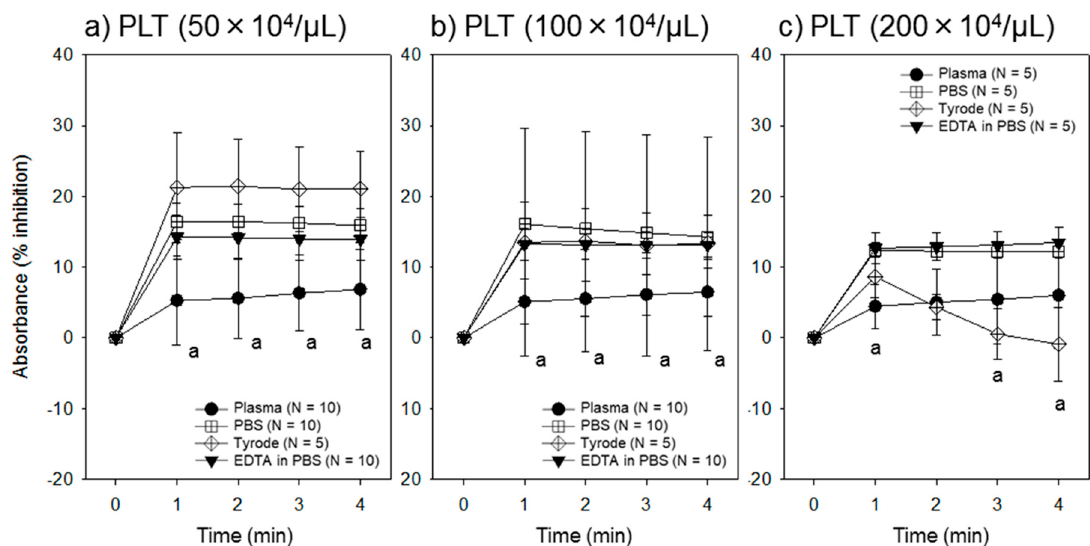
Figure 2. E ff ect of platelet density on ADP-induced platelet aggregation over a time course. Platelets were suspended in acellular plasma, PBS, Tyrode bu ff er solution, or EDTA-containing PBS at a density of ( a ) 50 × 10 4 / µ L, ( b ) 100 × 10 4 / µ L or ( c ) 200 × 10 4 / µ L and stimulated with 5 µ M ADP for up to 4 min